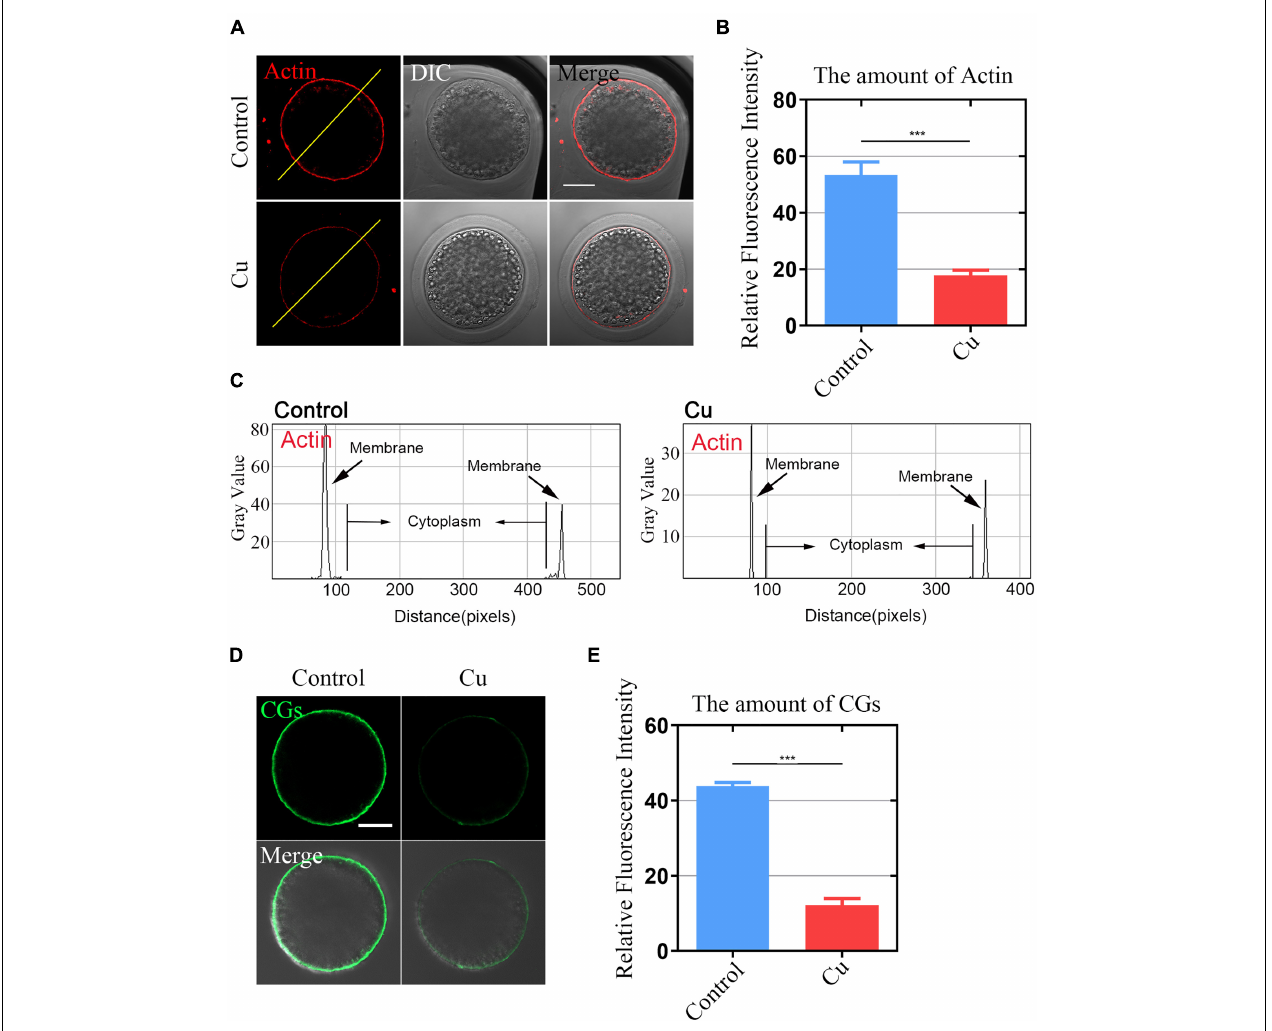
FIGURE 2 | Effects of Cu exposure on the distribution of actin and cortical granules dynamics in porcine oocytes. (A) Representative images of actin filaments in the control and Cu-exposed oocytes. Scale bar, 30 mm. (B) The fluorescence intensity of actin signals was measured in the control and Cu-exposed oocytes. (C) Right graphs showed fluorescence intensity profiling of phalloidin in oocytes. Lines were drawn through the oocytes, and pixel intensities were quantified along the lines. (D) Representative images of cortical granule localization in the control and Cu-exposed oocytes. Scale bar, 20 mm. (E) The fluorescence intensity of cortical granules was measured in the control groups and the Cu-exposed oocytes. Data of (B,E) were presented as the mean percentage of at least three independent experiments (mean ± SEM). *** P < 0.001.